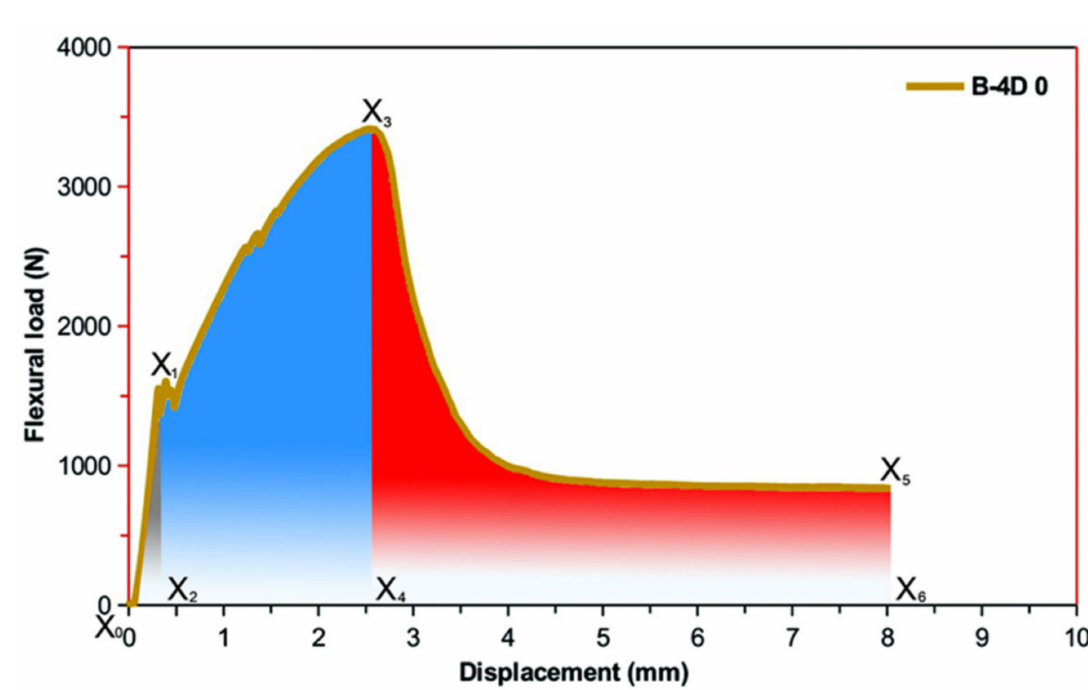
Figure 12. Representative presentation of areas under the load-displacement graph of the multiaxis 3D basalt fiber TOW concretes for the calculation of flexure energy of various stages including first crack, maximum load and